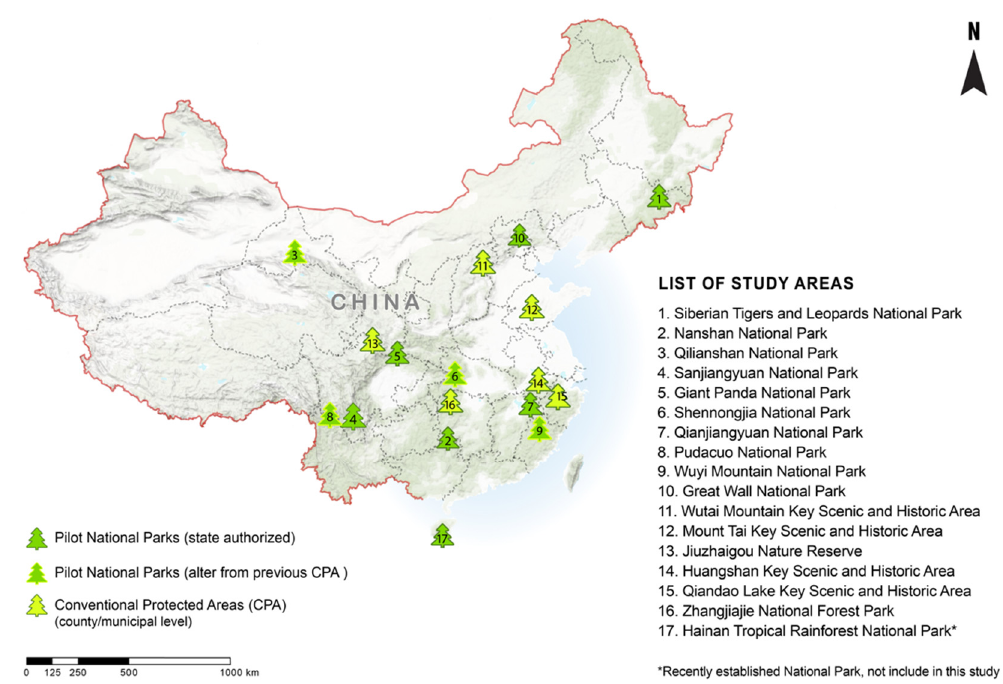
Figure 2. Map of study areas: the ten pilot national parks (PNPs) and the conventional protected areas (CPAs) included in the study.